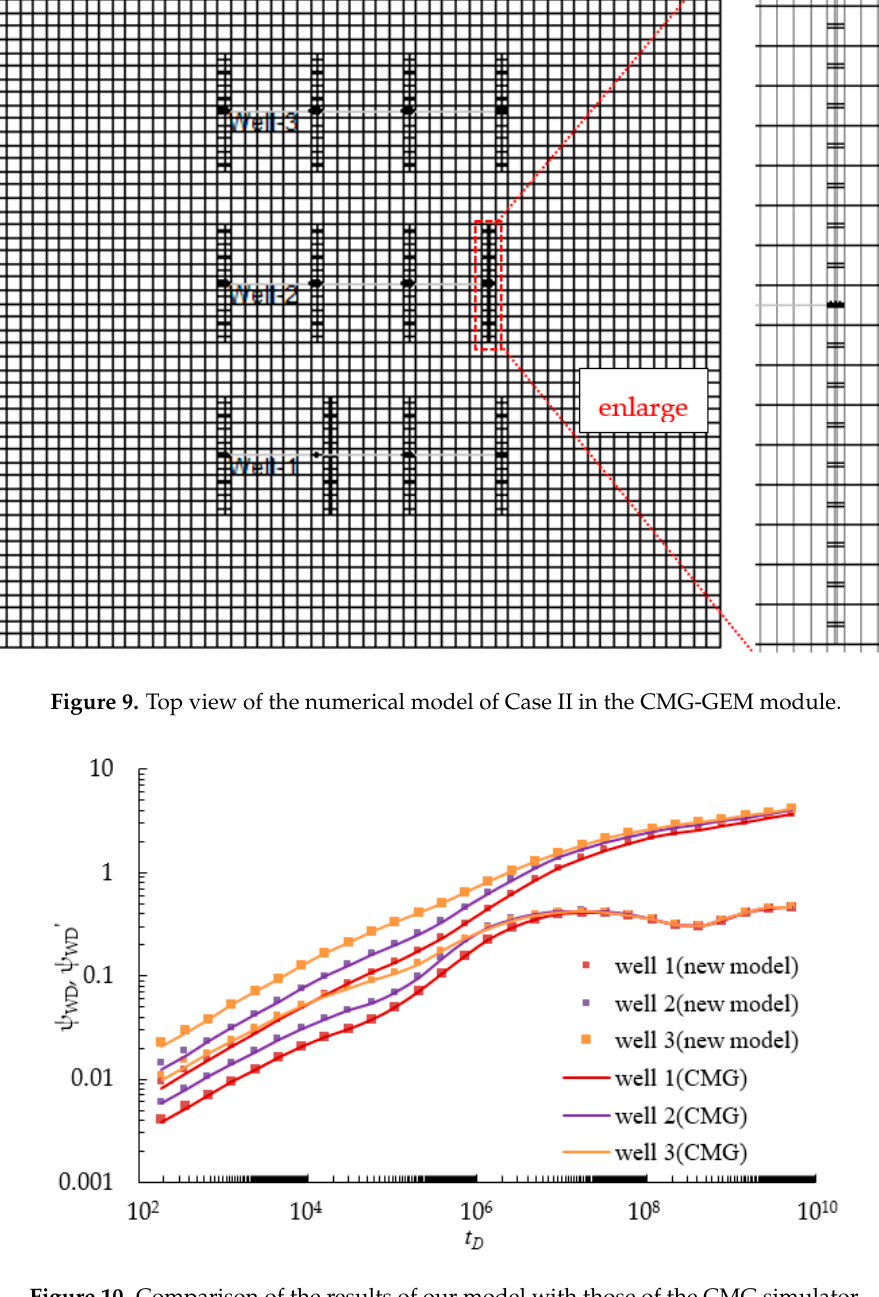
Figure 10. Comparison of the results of our model with those of the CMG simulator.